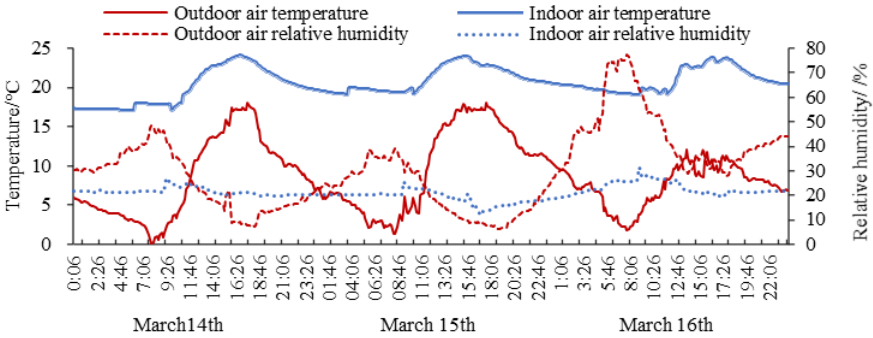
Figure 7. Outdoor and indoor air temperature and relative